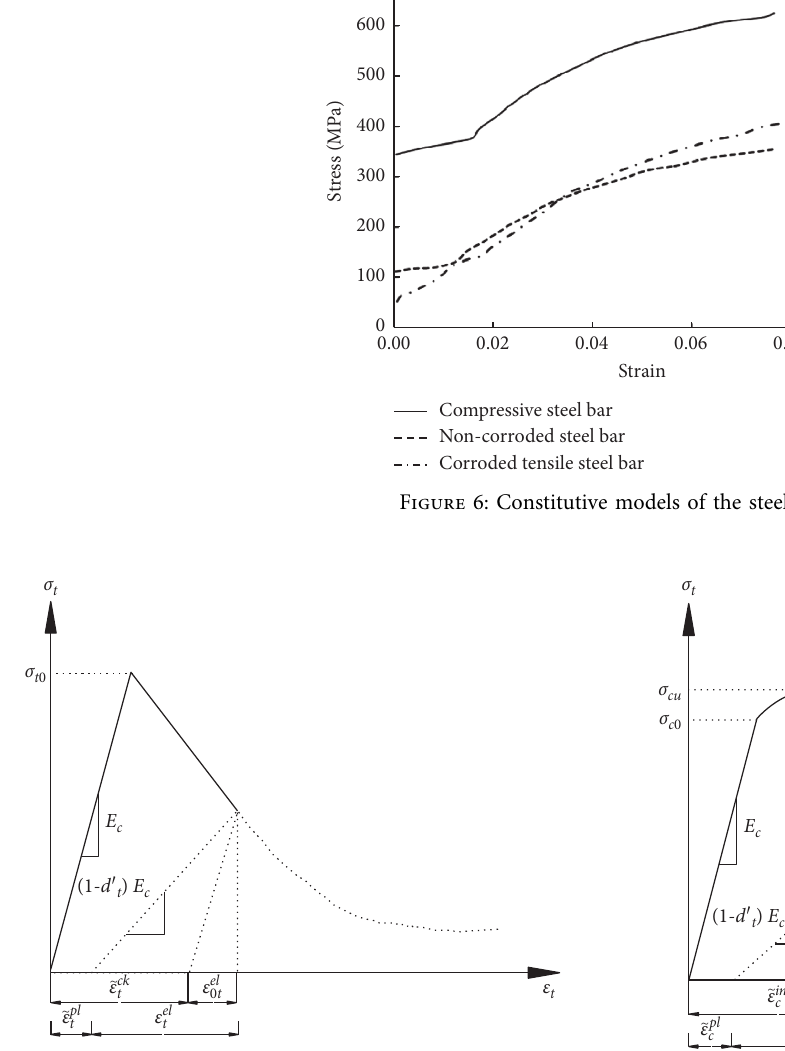
Figure 8: Definition of the compressive inelastic strain of the